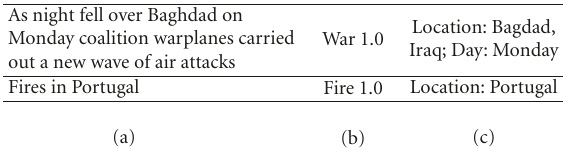
Figure 6: Linguistic analysis examples: (a) text transcripts (the first one coming from ASR and the second from OCR), (b) content- concept associations using the concepts of set C , (c) additional information in the form of locations, and so